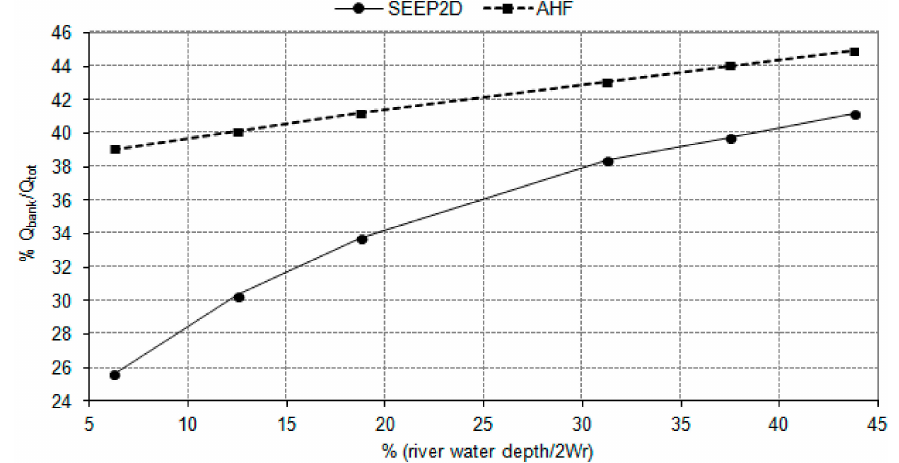
Figure 10. Two sided Q bank seepage contribution to total river flow Q tot (calculated with the SEEP2D and AHF models) as a function of the ratio of water depth ( H r –D a –d s ) to river width (2W r